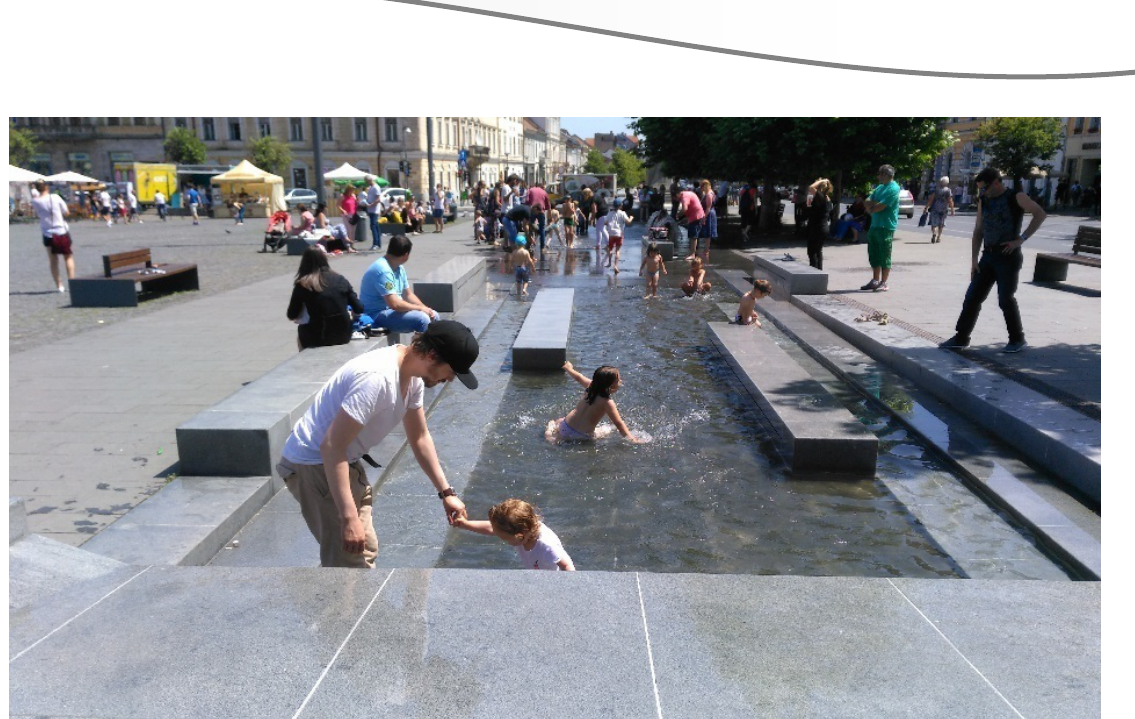
Figure 15: Specific activity during the hot days in the Union Square Source: Emanuel- Cristian ADOREAN, 2016©